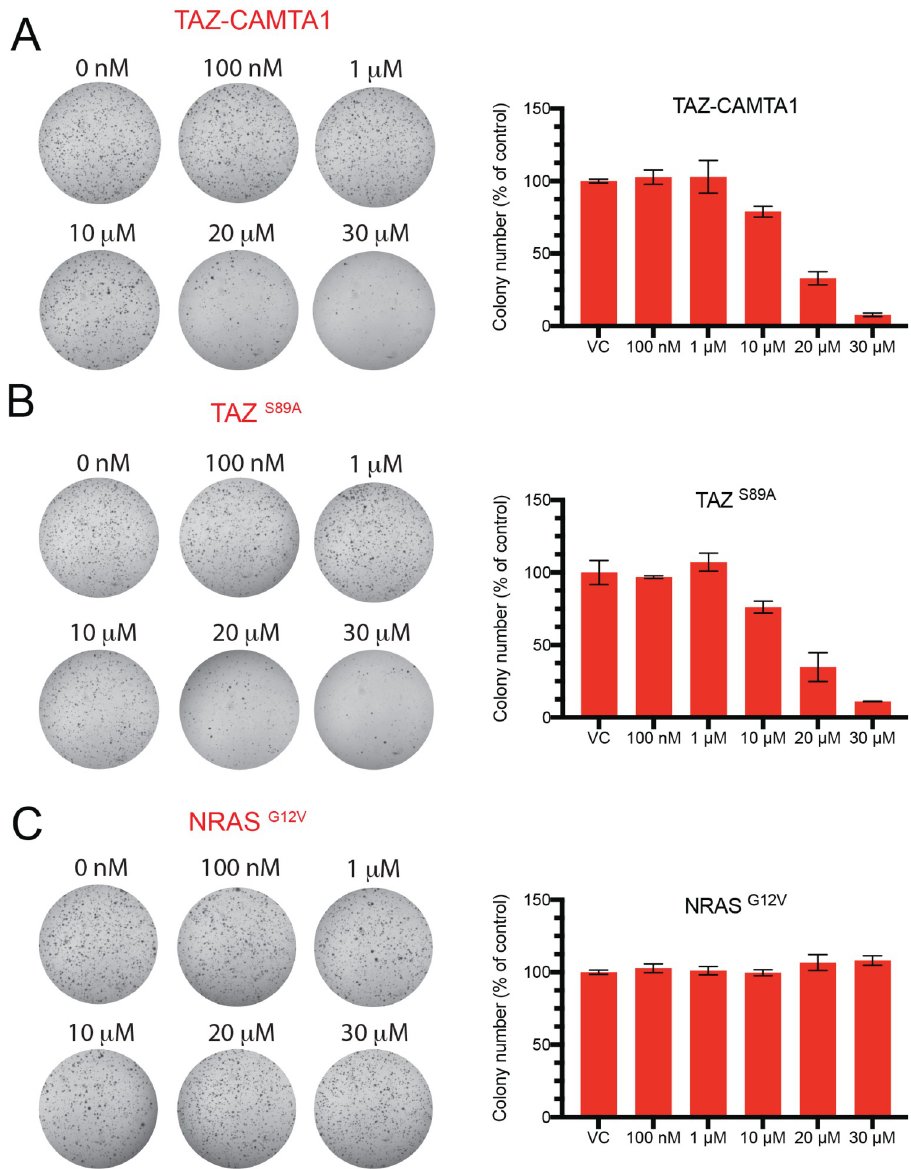
Fig 4. ATA inhibits soft agar colony growth that is dependent on TC/TAZ-TEAD activity. Bright-field images and the corresponding quantification of soft agar colonies determined as percent normalized to vehicle controls (VC). Cells were treated with the indicated doses of ATA in (A) NIH3T3 cells expressing TAZ-CAMTA1 (B) NIH3T3 expressing TAZ S89A and (C) NIH3T3 cells expressing NRAS G12V . Data represent results of two independent experiments. Data are presented as mean (n = 3) and error bars represent the standard deviation of the